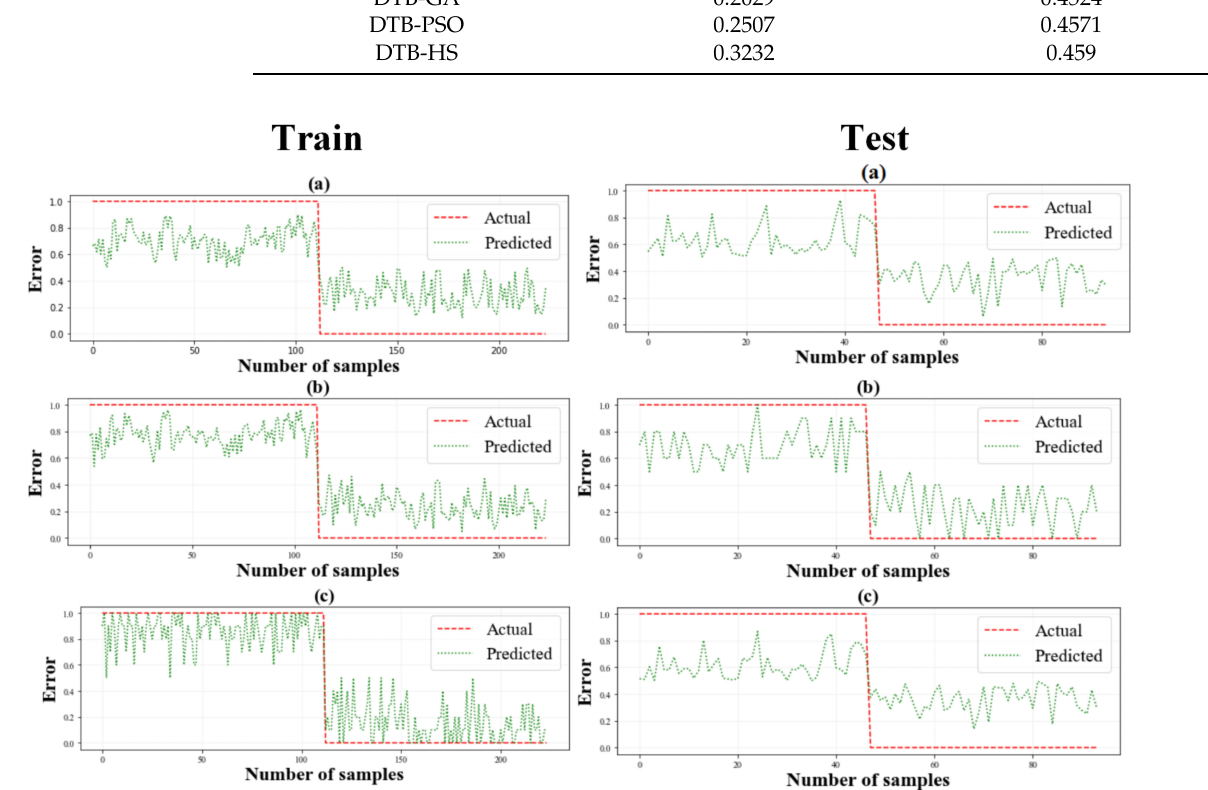
Figure 8. Diagrams of modeling error with: ( a ) DTB-HS, ( b ) STB-PSO, and ( c ) DTB-GA